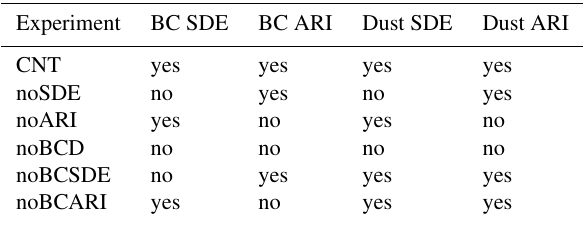
Table 2. Listing of WRF-Chem experiments organized by the types of LAP effects included in each